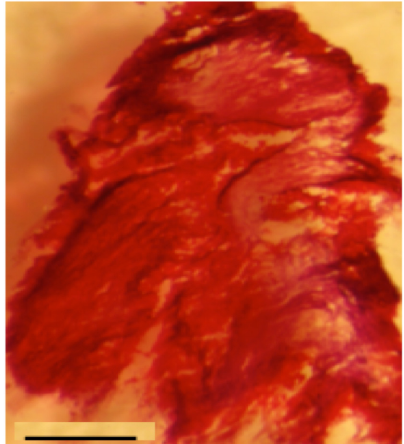
Figure 3. Alizarin Red staining of PCL scaffold seeded with Osteoblasts microtissues: In vitro bone induction and mineralization on the PCL electrospun nanofibers seeded with microtissues after 28 days of in vitro culture. Scale bar = 1 mm. n = 3.